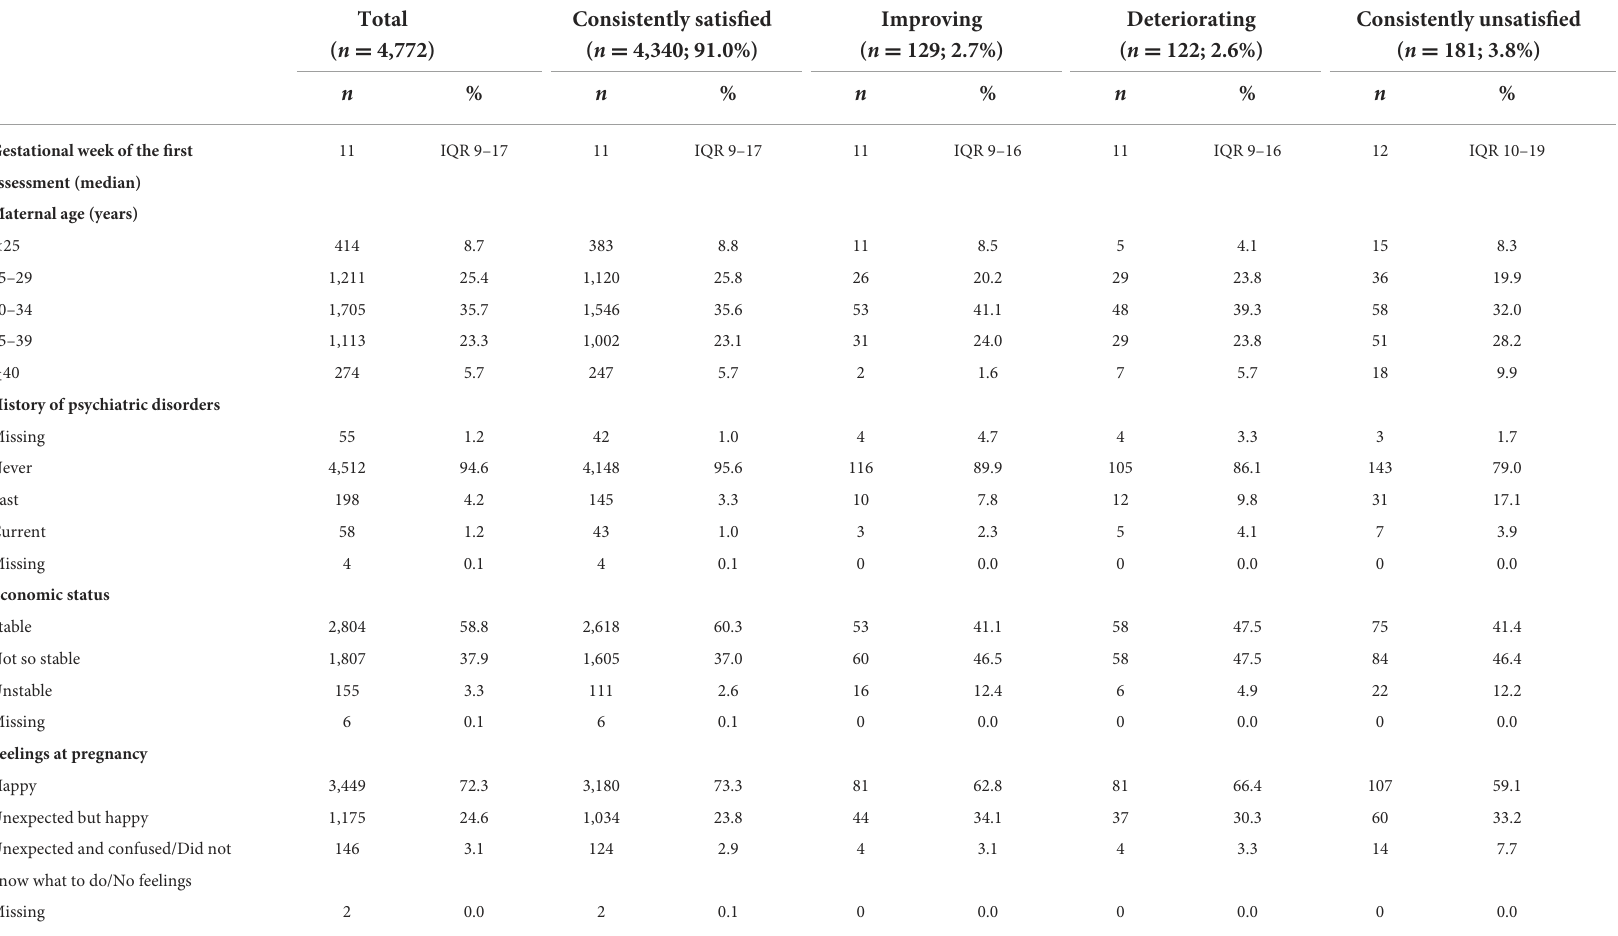
TABLE 1 Descriptive characteristics of the study participants at